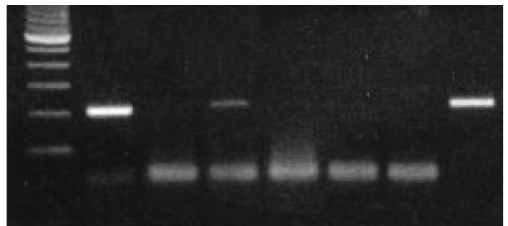
Figure 2: Agarose gel analysis of endometrial adenocarcinomas by PCR using HPV 18 type-specific primers. Line 1 (marker 100bps), lines 2, 4 (positive samples), lines 3, 5, 6 (negative samples), line 7 (negative control), and line 8 (positive